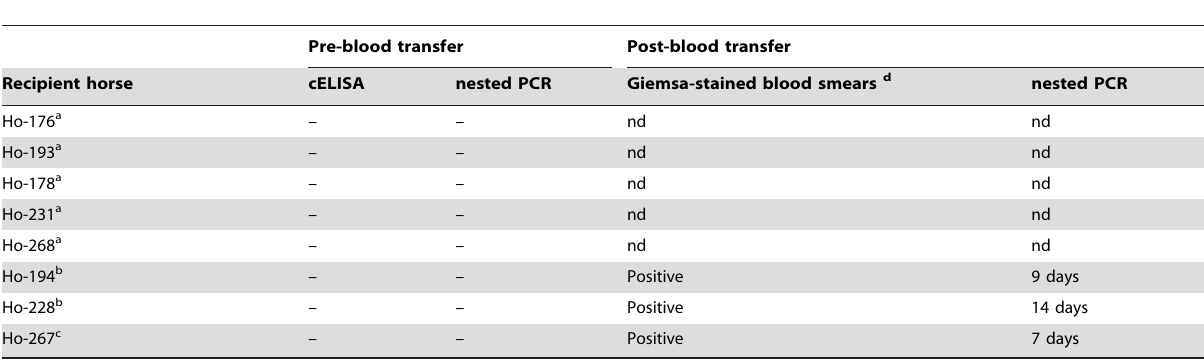
Table 2. Blood transfer following imidocarb dipropionate treatment into naı¨ve